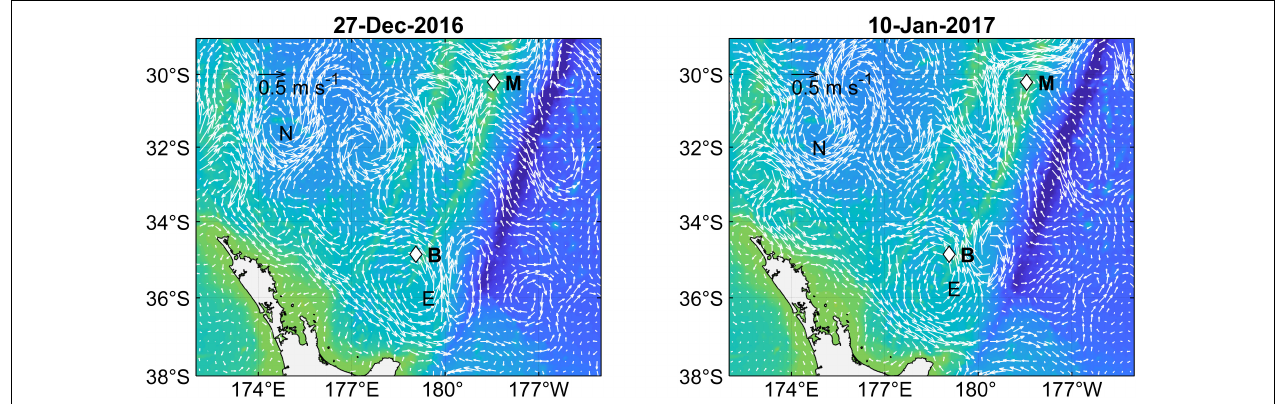
FIGURE 4 | Surface currents derived from satellite-altimeter measurements in the study area on December 27th 2016 (midpoint of the Macauley sampling) and January 10th 2017(midpoint of the Brothers sampling). B stands for Brothers and M for Macauley. The North Cape and East Cape Eddies are shown as N and E.